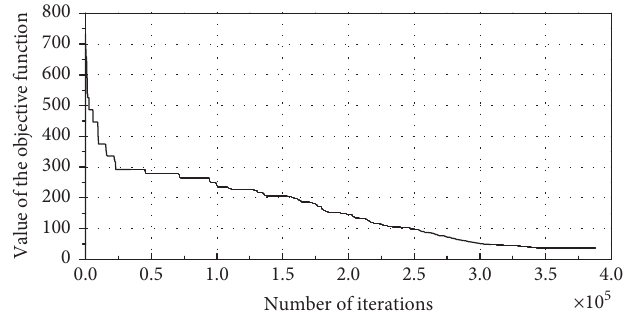
Figure 4: Evolution curve of the